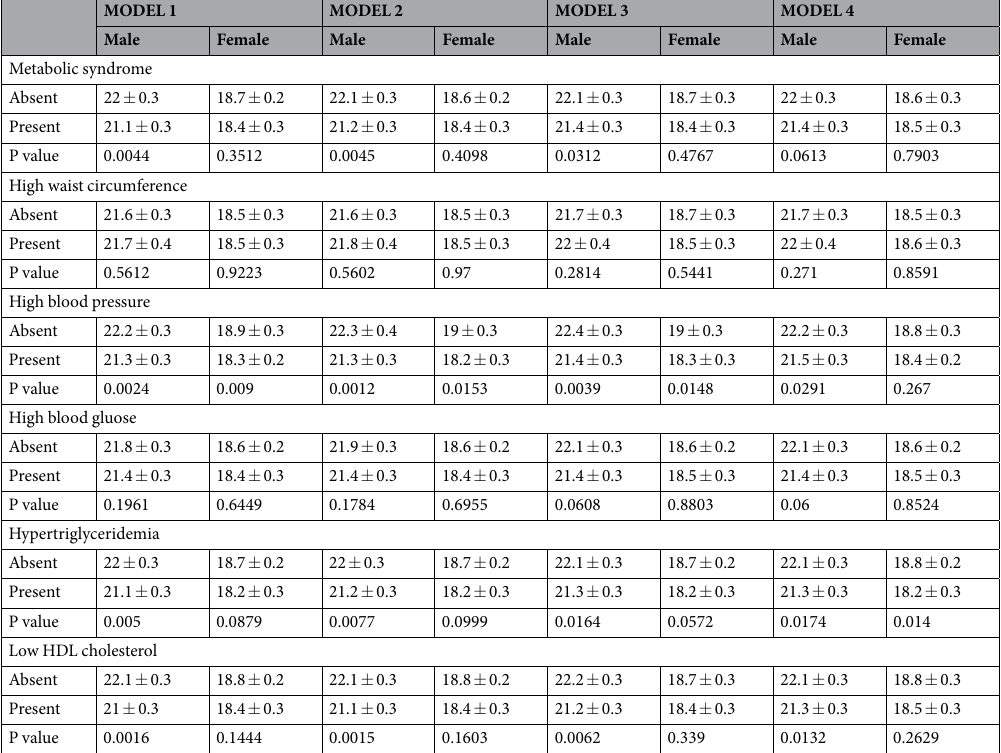
Table 3. Comparison of vitamin D levels between groups according to presence or absence of metabolic syndrome or its components. MODEL 1 non–adjusted. MODEL 2 age, sex. MODEL 3 age, sex, smoke, exercise,